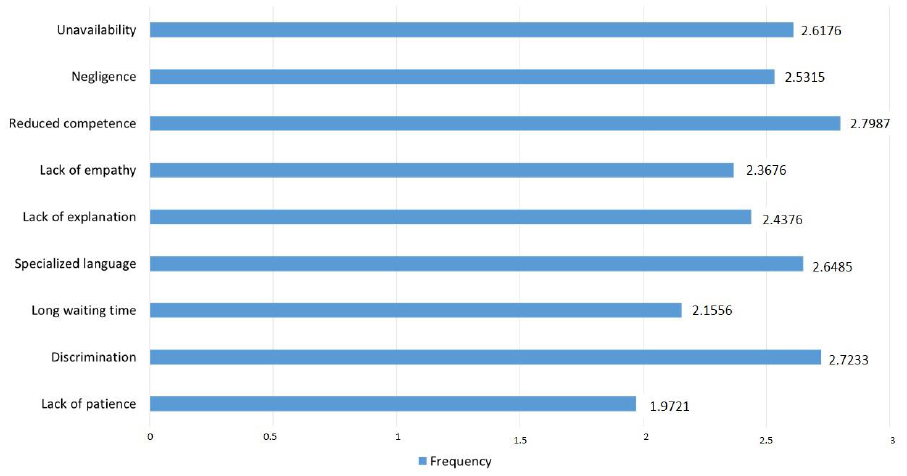
Figure 1. Reasons for patient dissatisfaction.